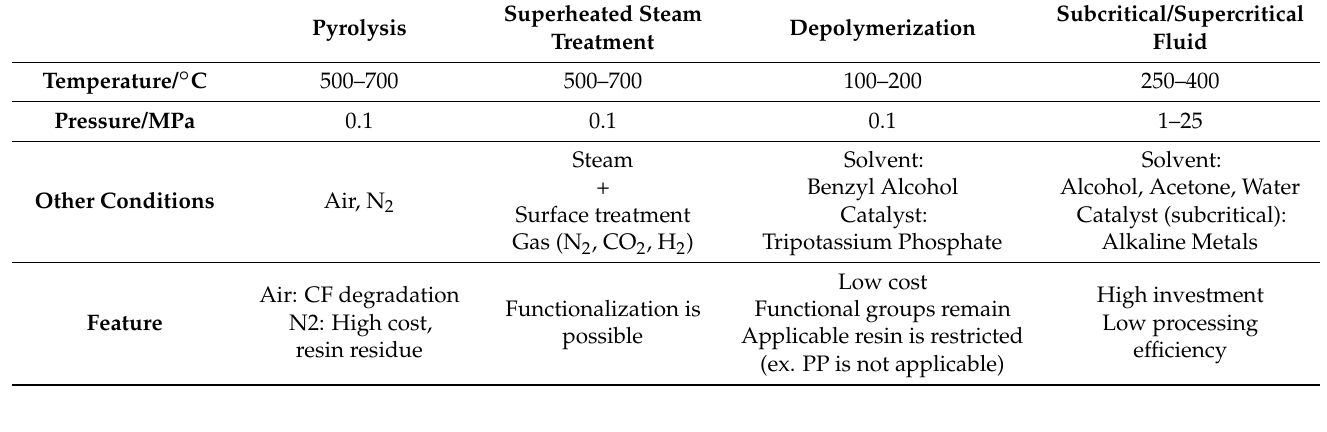
Table 1. Methods for CFRP recycling.